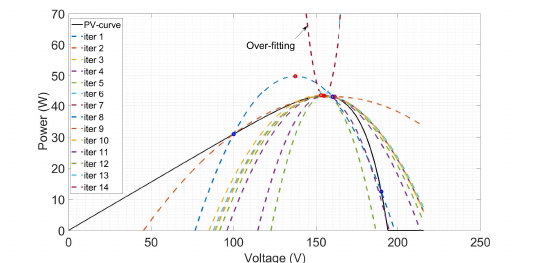
Figure 20. Overfitting case of